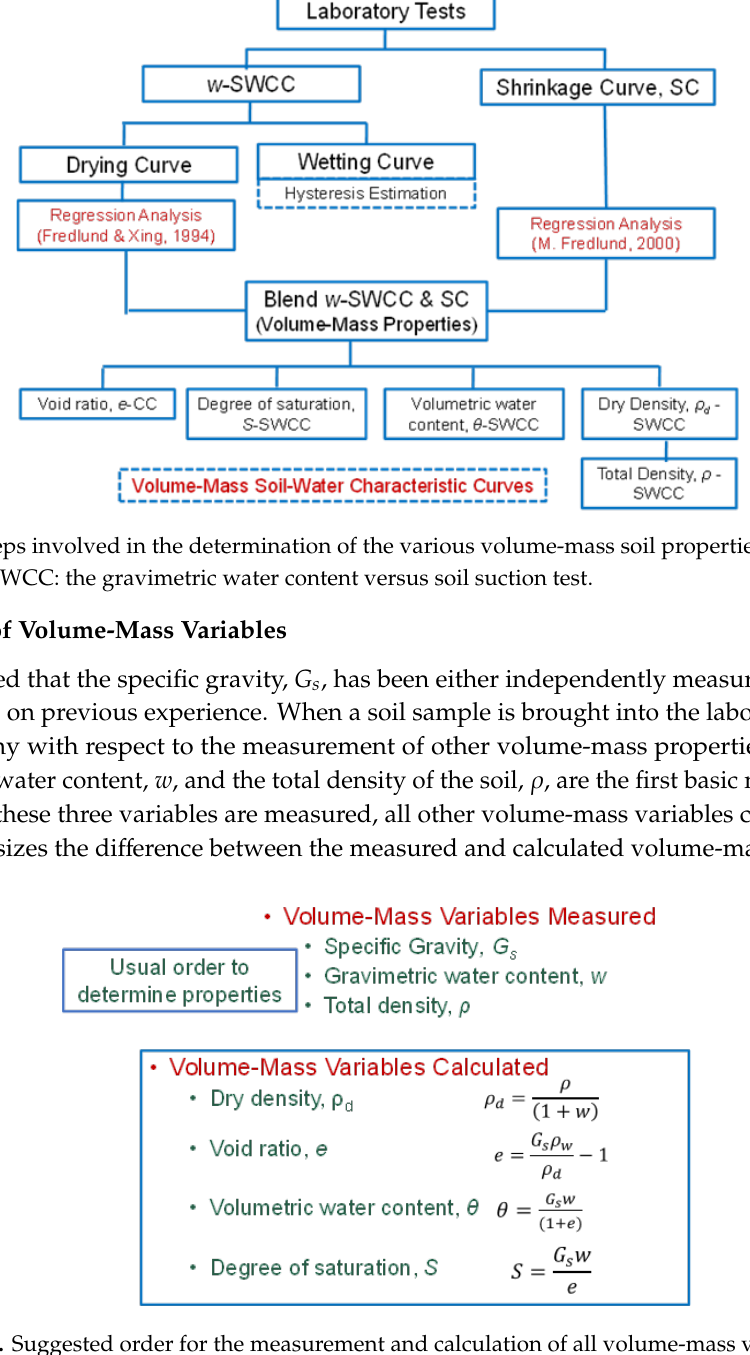
Figure 2. Suggested order for the measurement and calculation of all volume-mass variables.